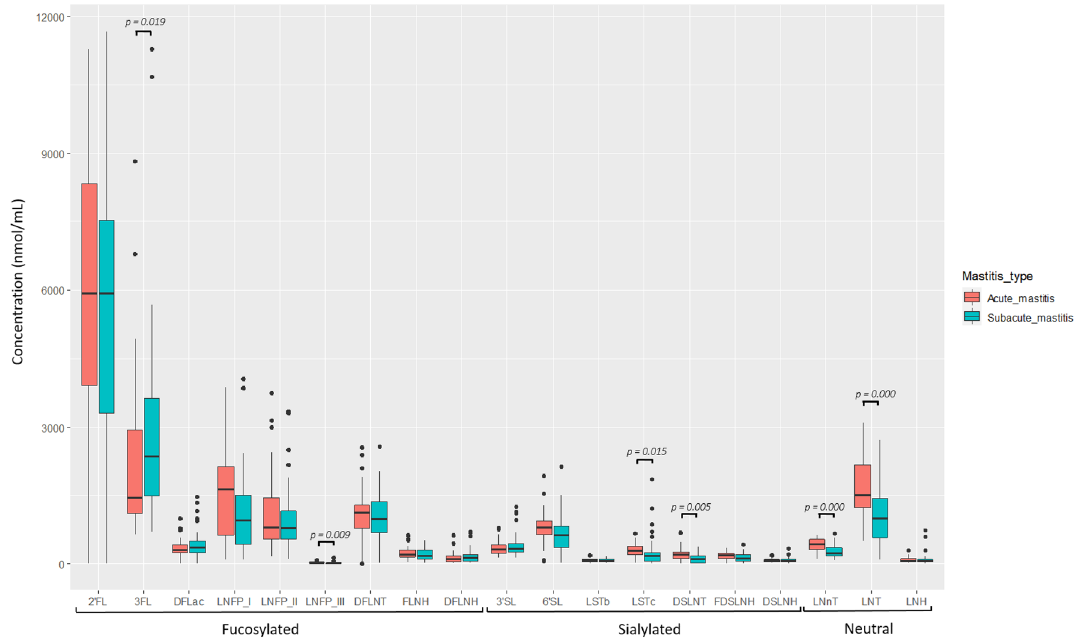
Figure 4. Box-plots showing the concentrations (nmol/mL) of the individual HMOs. The boxes represent the values of the interquartile ranges, with the median represented as a line. Outliers are represented as dots. Samples colored in red belong to acute mastitis (AM) cases and those in green to subacute mastitis (SAM) cases. Wilcoxon rank sum tests or ANOVA tests (depending on the distribution of the data) were used to determine differences in HMOs concentration between samples from acute or subacute mastitis-suffering women. DFLac, difucosyllactose; DFLNH, difucosyllacto- N -hexaose; DFLNT, difucosyllacto- N -tetrose; DSLNH, diasilyllacto- N -hexaose; DSLNT, diasilyllacto- N -tetraose; FDSLNH, fucodisialyllacto- N -hexaose; FLNH, fucosyllacto- N - hexaose; HMO, human milk oligosaccharide; LNFP, lacto- N -fucopentaose; LNH, lacto- N -hexaose;